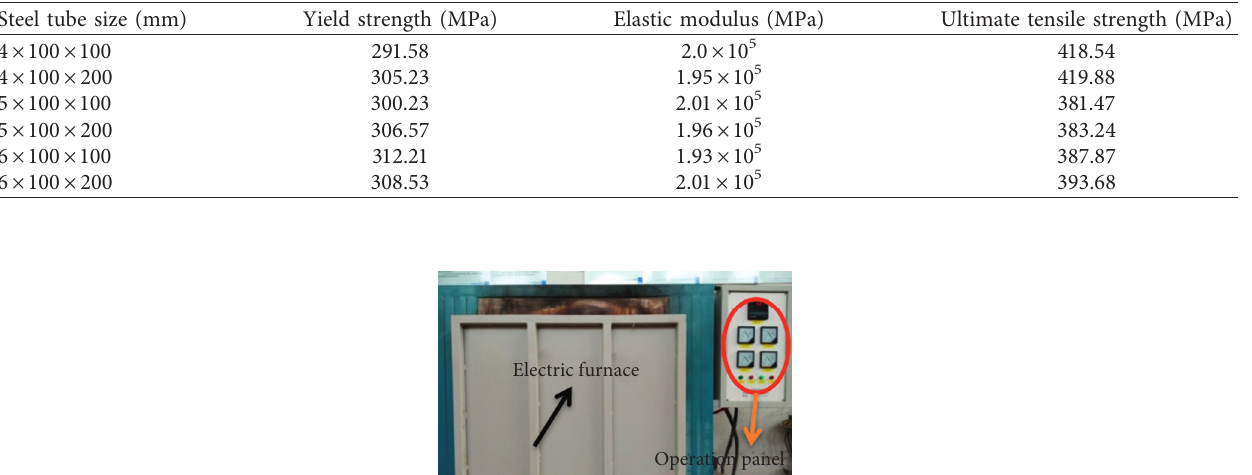
Table 4: Experimenting parameter of